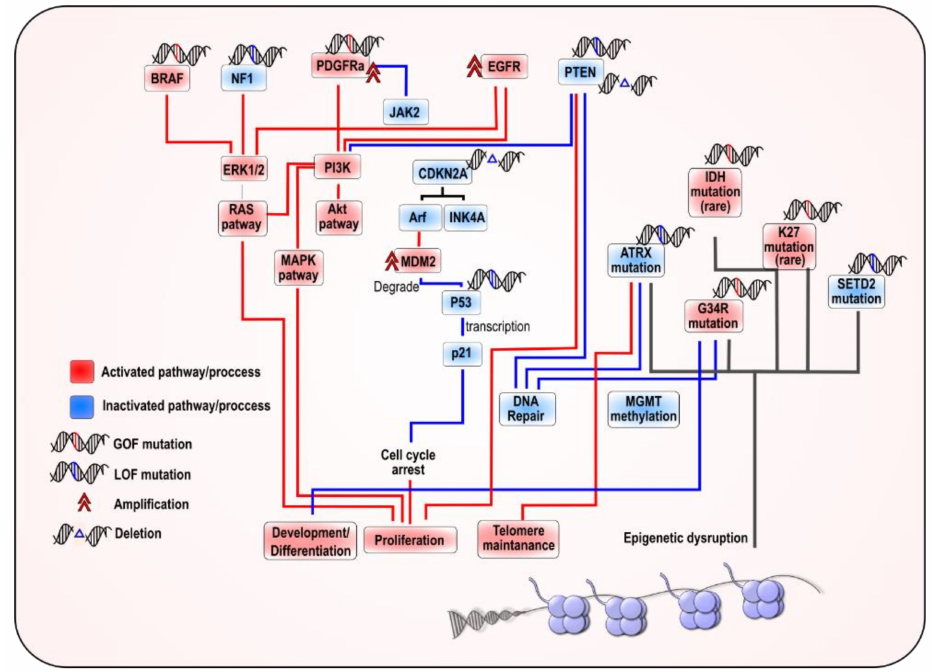
Figure 1. Illustration depicting the main pathways altered in hemispheric pediatric high-grade gliomas (pHGG): The main genetic alteration associated with pathways alterations are